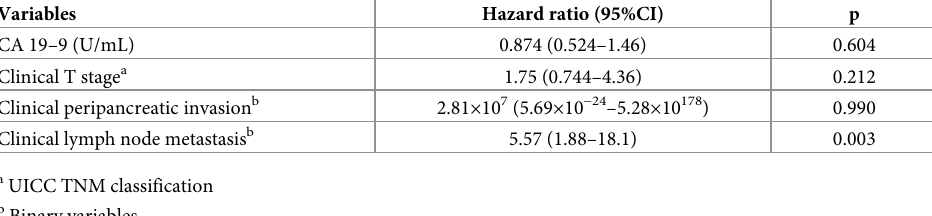
Table 2. Multivariate analysis of patients’ preoperative